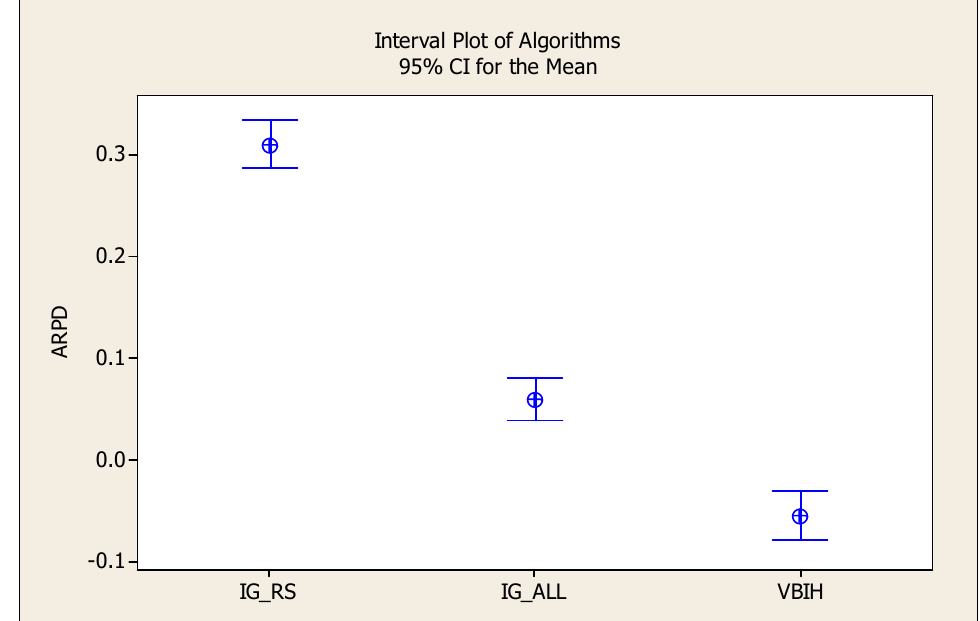
Figure 7. Interval plot at the 95% confidence level for large VRF instances.